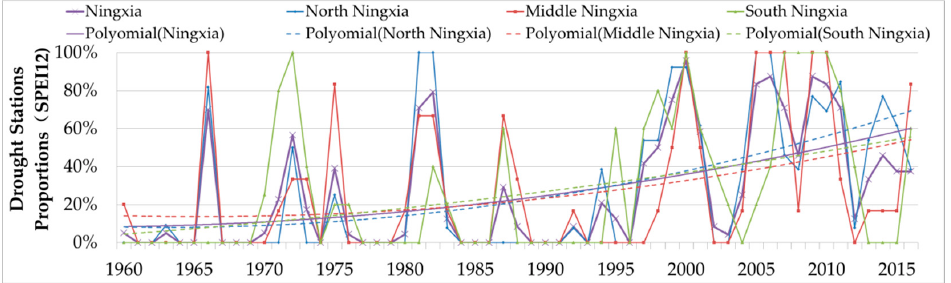
Figure 4. The drought stations proportions of the SPEI12 in three sub-regions and the whole Ningxia regions from 1960 to 2016.